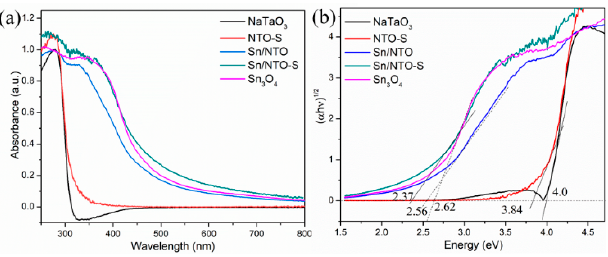
Figure 4. UV–vis diffuse reflectance spectra (DRS) ( a ) and the calculated band gaps ( b ) of different samples: NaTaO 3 , NTO-S, Sn/NTO, Sn/NTO-S (molar ratio Sn:Ta = 1:1) heterostructure, and Sn 3 O 4 .